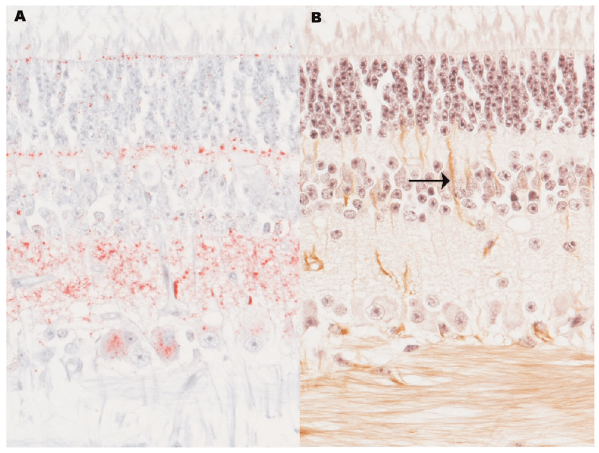
Figure 2. Retinal pathology corroborates antemortem findings. ( A ) PrP Sc immunoreactivity demonstrates that abundant PrP Sc (red) accumulates in the retina. Original magnification 20 6 . ( B ) GFAP immunoreactivity (brown) in the Mu¨ller glia (arrow) indicates a response to retinal injury. Original magnification 20 6 .